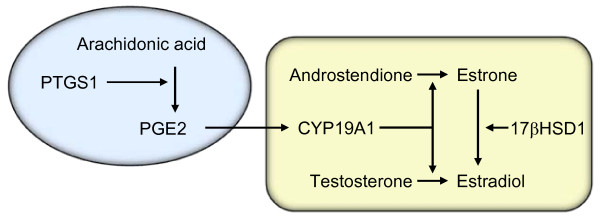
Schematic illustration of mechanism of action of PTGS1. PTGS1 induces PGE2-production. PGE2 increases the expression of aromatase (CYP19A1) which in turn converts androgens to estrogens in adipose tissue. 17βHSD1 = 17β-hydroxysteroid dehydrogenase.